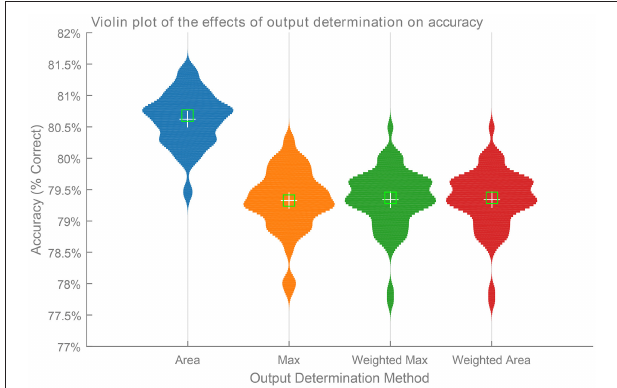
FIGURE 6 | Comparison of the effects of the four different output determination methods on classification accuracy with a Gaussian training pattern. The figure shows the distribution of classification accuracies over 61 trials of a SKIM network with 1000 hidden layer neurons. Each network made use of the same random training order and hidden layer configuration, with only the random weights varying from trial to trial. The network made use of a Gaussian training pattern and uses the four different classification methods shown in Figure 3 .